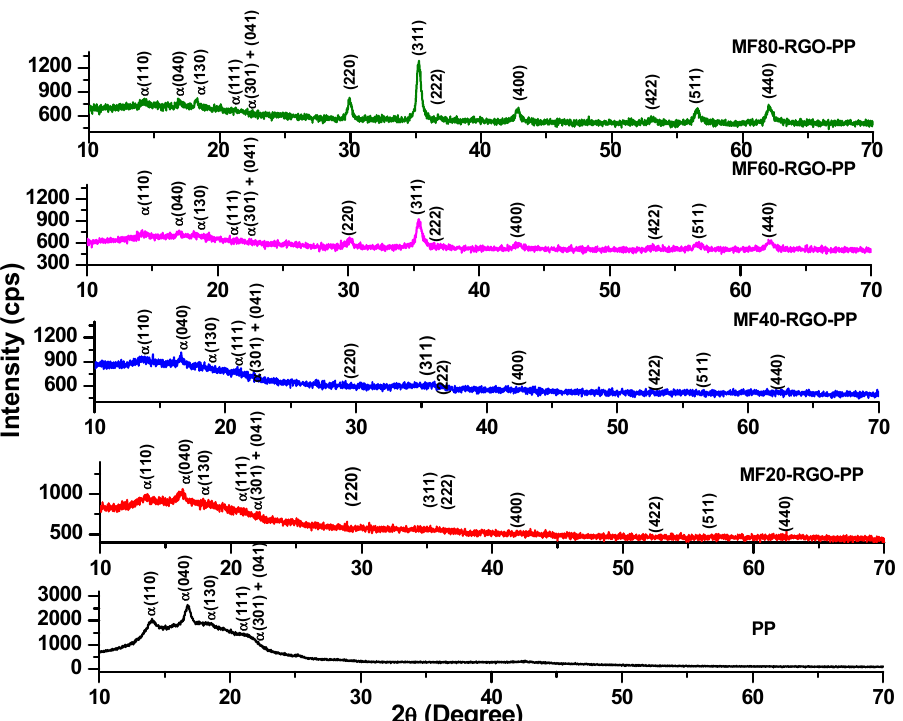
Figure 4. XRD pattern of polypropylene (PP) and prepared nanocomposites MF20-RGO-PP, MF40-RGO-PP, MF60-RGO-PP and MF80-RGO-PP.